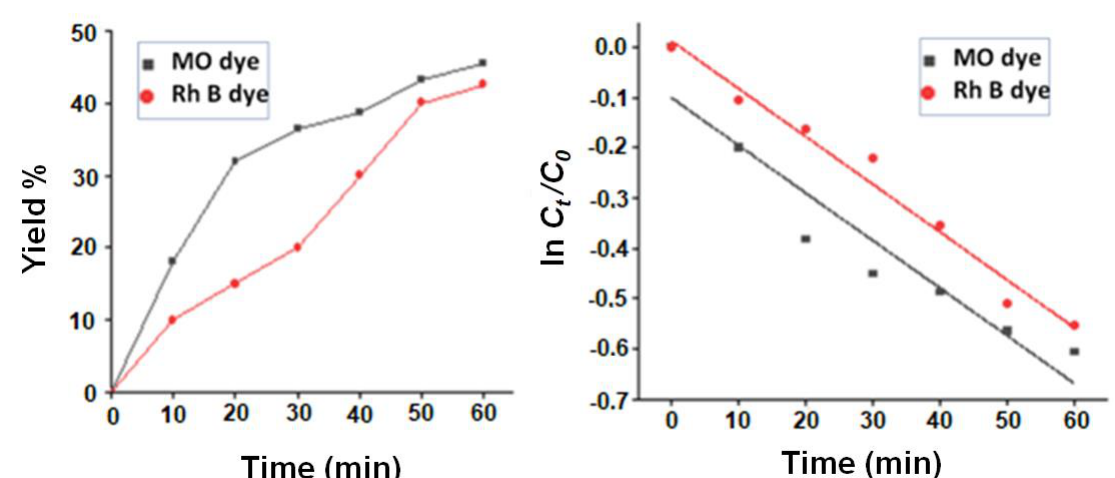
Figure 4. (Left) Changes in C t / C o versus time for the following conditions: H 2 O 2 + MO + complex ( 4 ) and H 2 O 2 + Rh B + complex ( 4 ). (Right) Kinetics of complex ( 4 )-catalyzed degradation of MO and Rh B in aqueous solution.